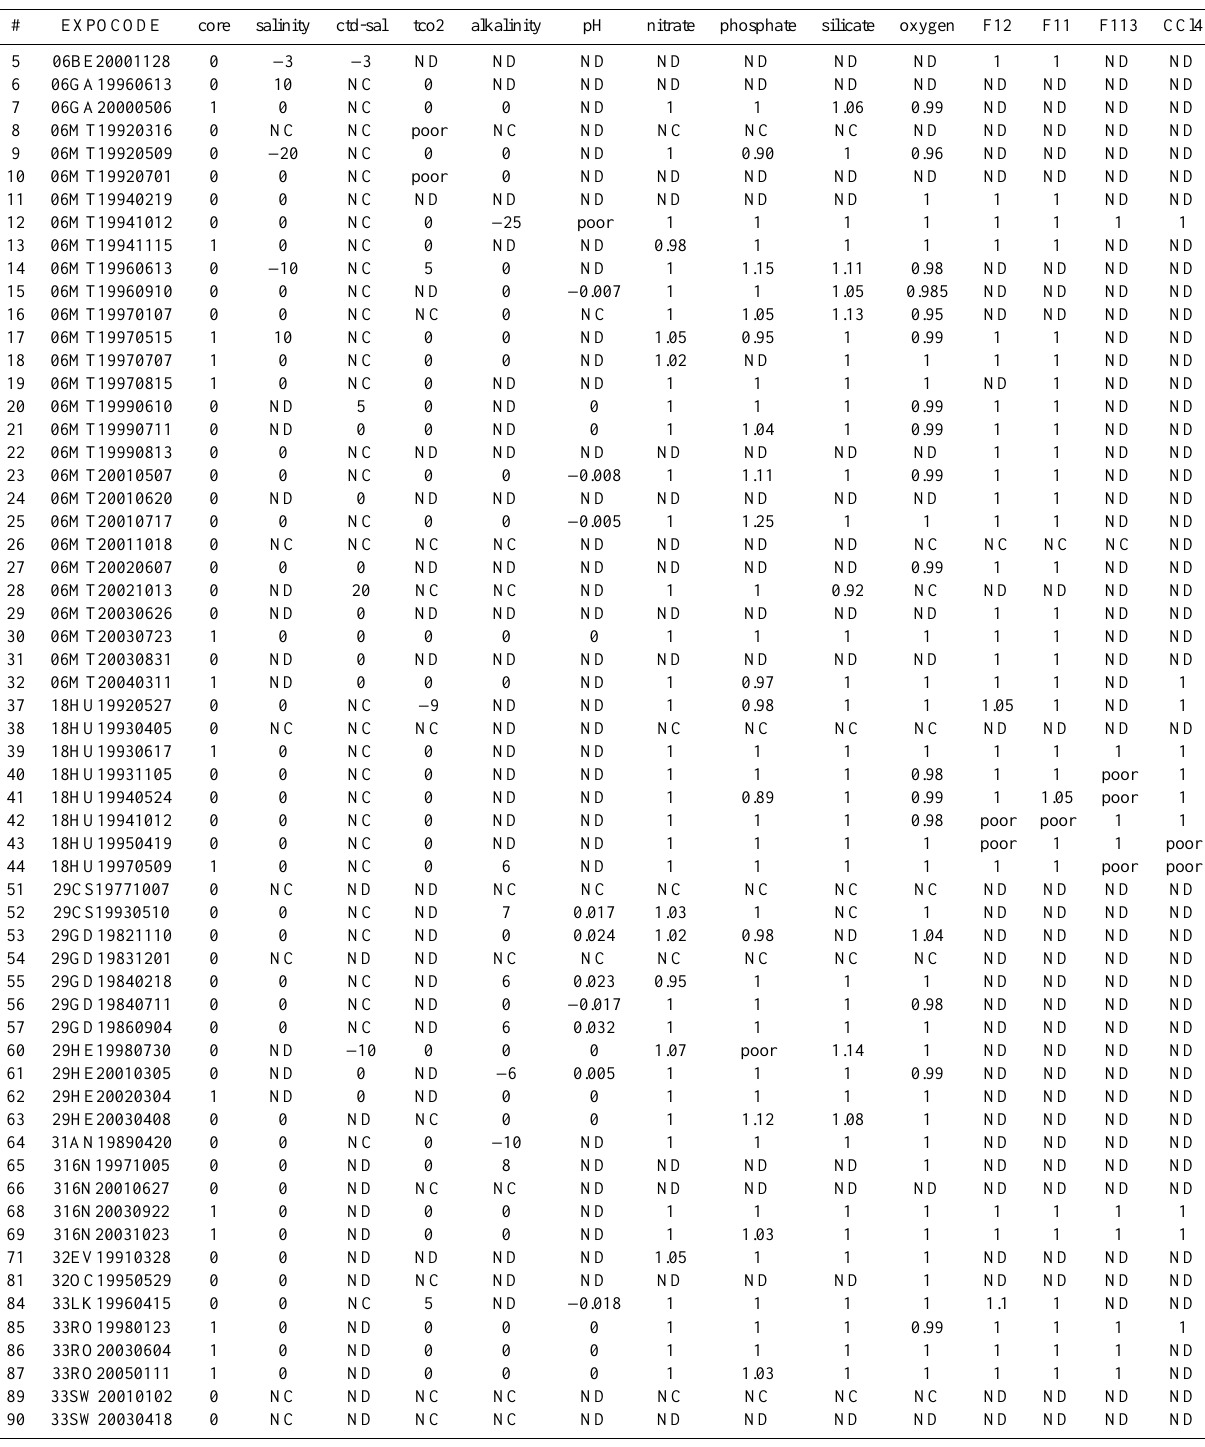
Table 1. This table lists all cruises in the CARINA dataset that are part of the Atlantic Ocean subset, and the additional reference cruises that were used for consistency with historical cruises (i.e. GLODAP). The table lists: CARINA cruise #; EXPOCODE; cruises used as core cruises (1) in the analysis; and adjustment values applied to the data product, additive for: Salinity (ppm), ctdsal (ppm), total